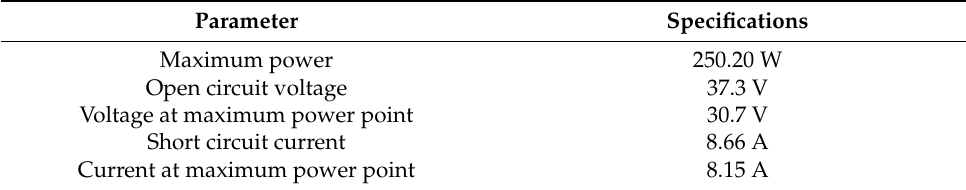
Figure 5. MPPT control for the PV system. Table 1. Parameters and specifications of PV